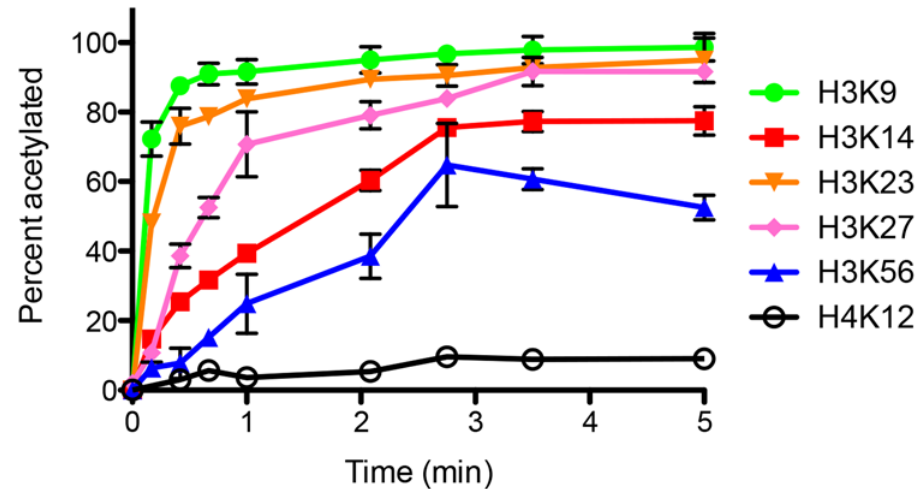
Fig 1. Time course study of acetylation on individual lysine residues of H3/H4 catalyzed by Rtt109- Vps75. The error bar indicates the standard error in acetylation percentage from three sets of assays. This assay indicates that H3K9 and H3K23 are the primary sites acetylated by Rtt109-Vps75, while H3K56 acetylation is modest.